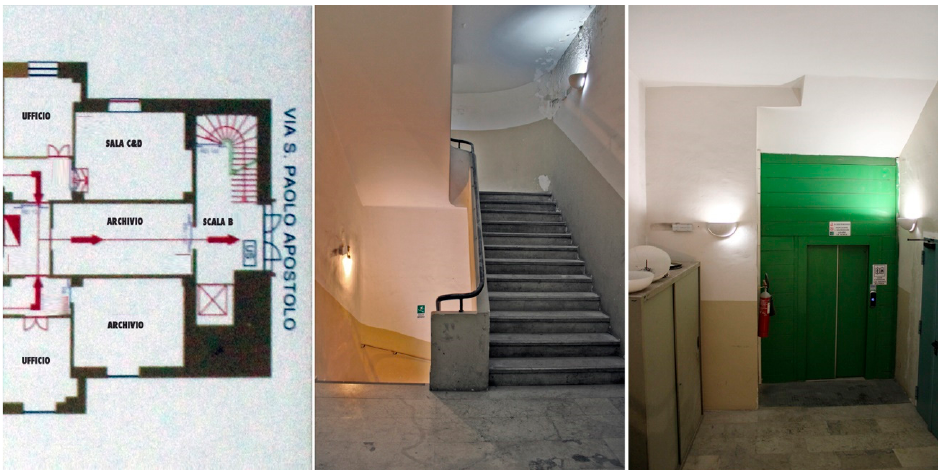
Figure 11. The transformations of the 1970s: the assembly hall becomes an archive and the main staircase welcomes an elevator that interrupts its monumentality.